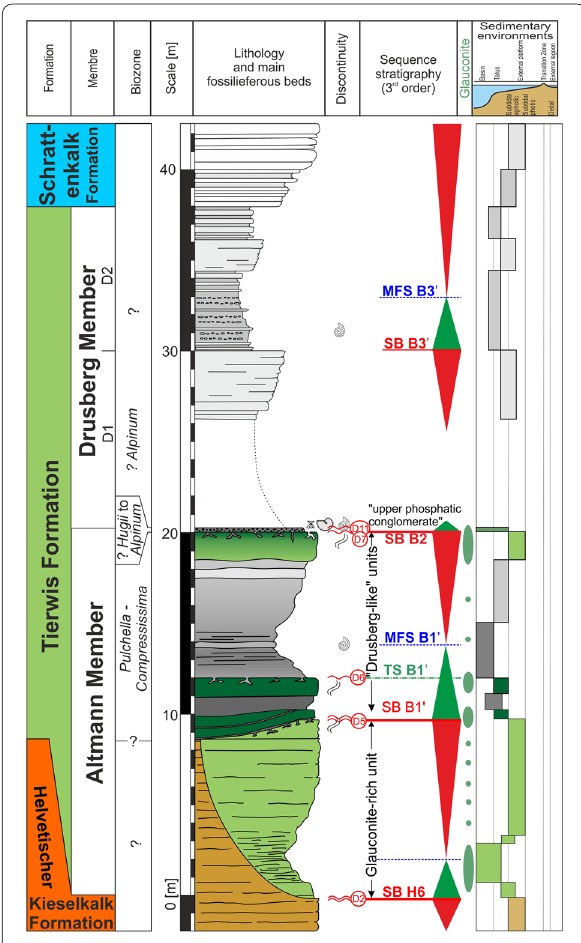
Fig. 12 Litten-Chreialp section. Lithological log with mains fossil-bearing levels, discontinuities, sequence stratigraphic interpretations and